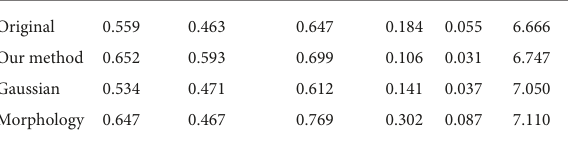
TABLE 2 Evaluation of reducing the lighting